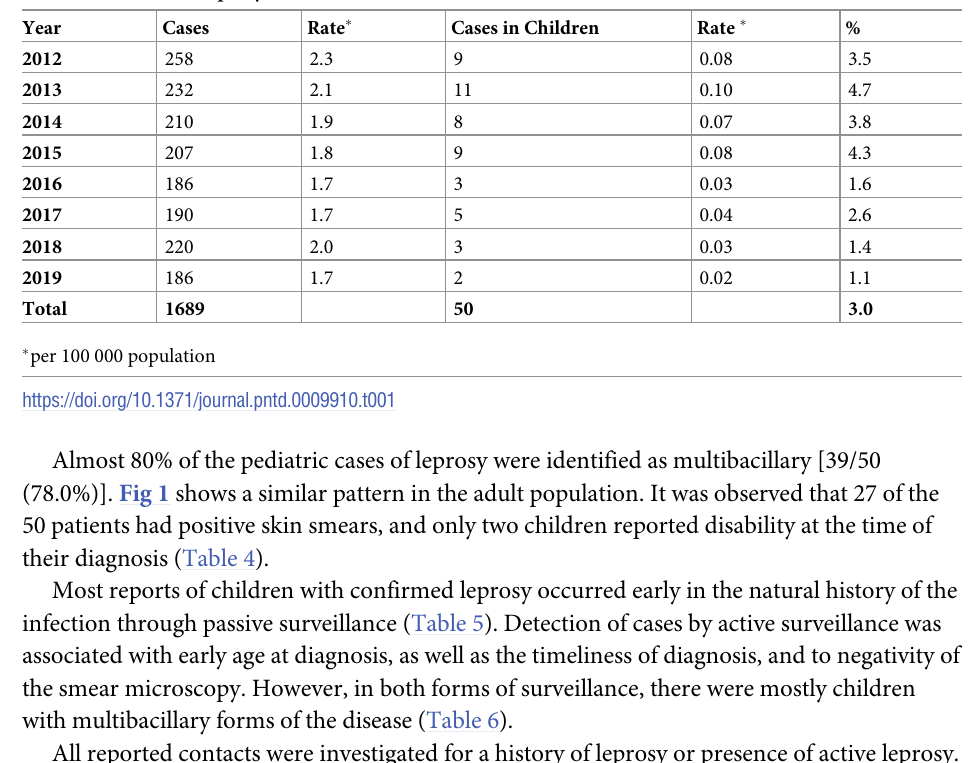
Table 1. Detection of leprosy cases in adults and children in Cuba